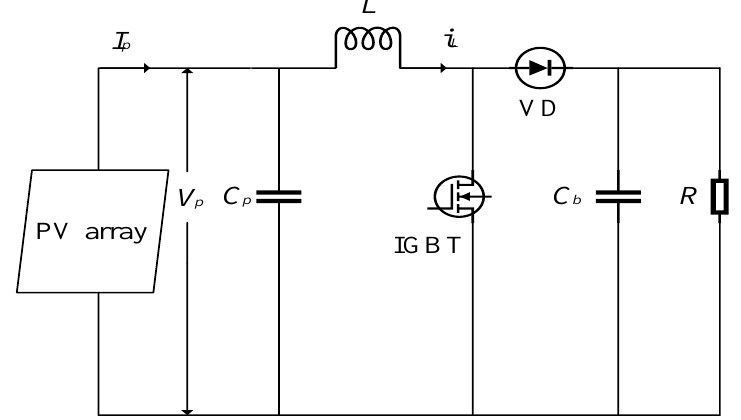
Figure 1. Equivalent circuit of photovoltaic power generation system.